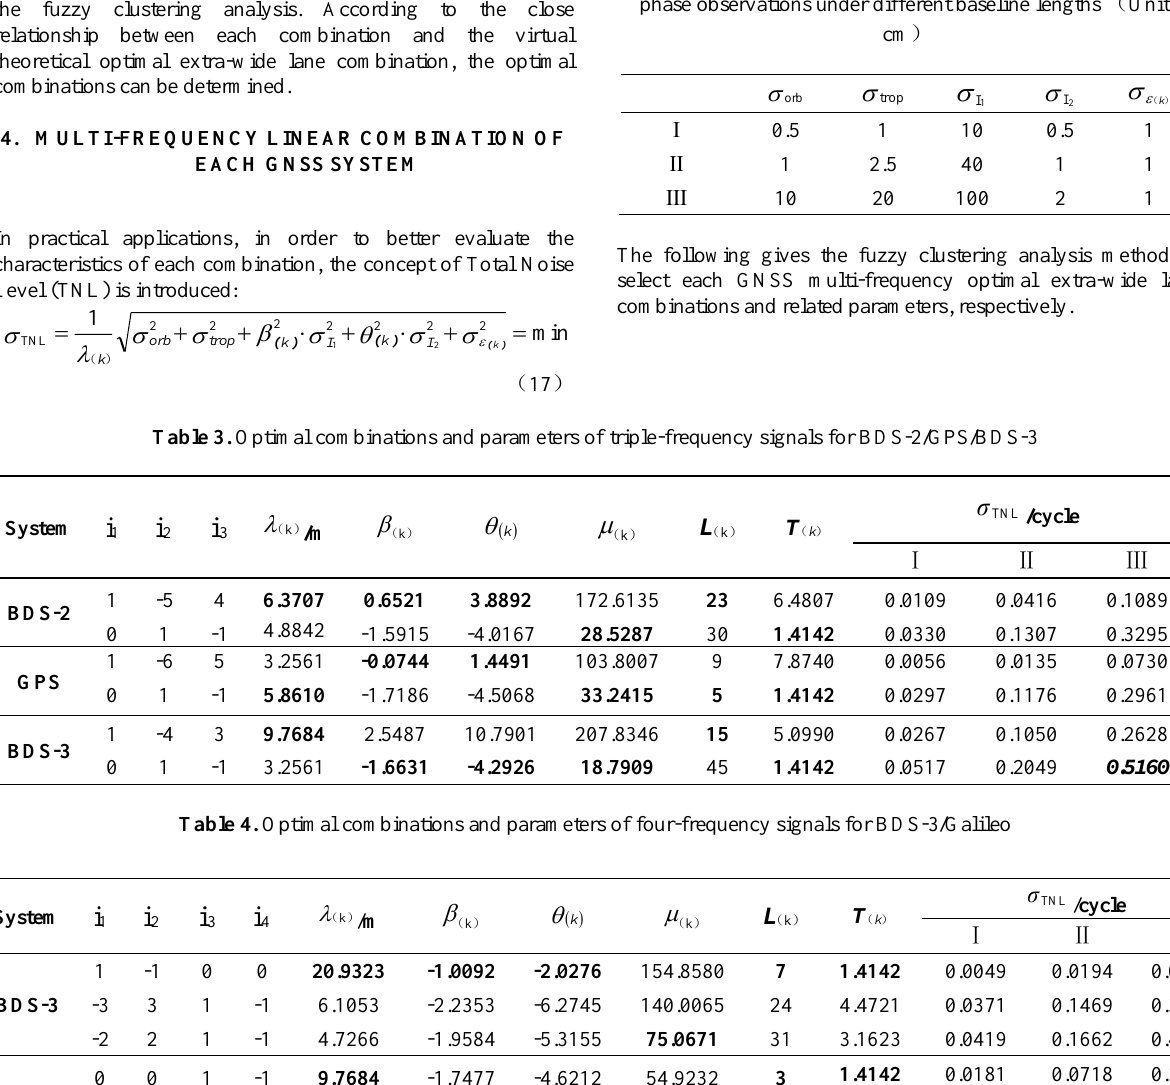
Table 2. The specific error precisions of double-differenced